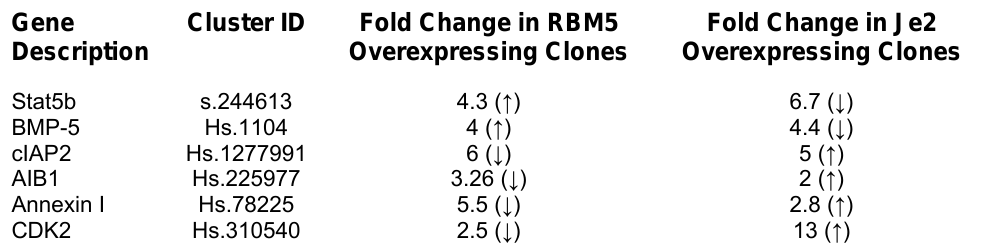
Reciprocal Changes of Six Key Genes as a Result of LUCA-15 and Je2 Overexpression (Microarray-based